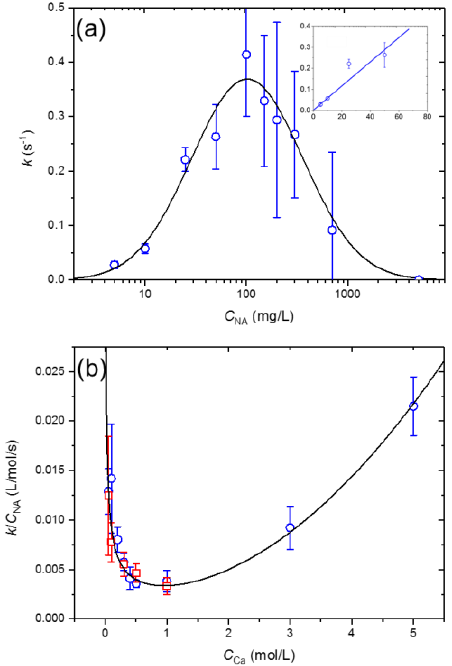
Figure 5. ( a ) The effect of NA concentration on the first-order kinetic rate constant for equilibration of the n -heptane/water interfacial tension in the presence of 0.3 mol/L Ca 2+ ions. The inset shows the second-order plot for low NA concentrations. ( b ) The effect of Ca 2+ concentration on the second-order rate constant in the low NA concentration range (red and blue symbols are for C NA = 5 and 10 mg/L, respectively).